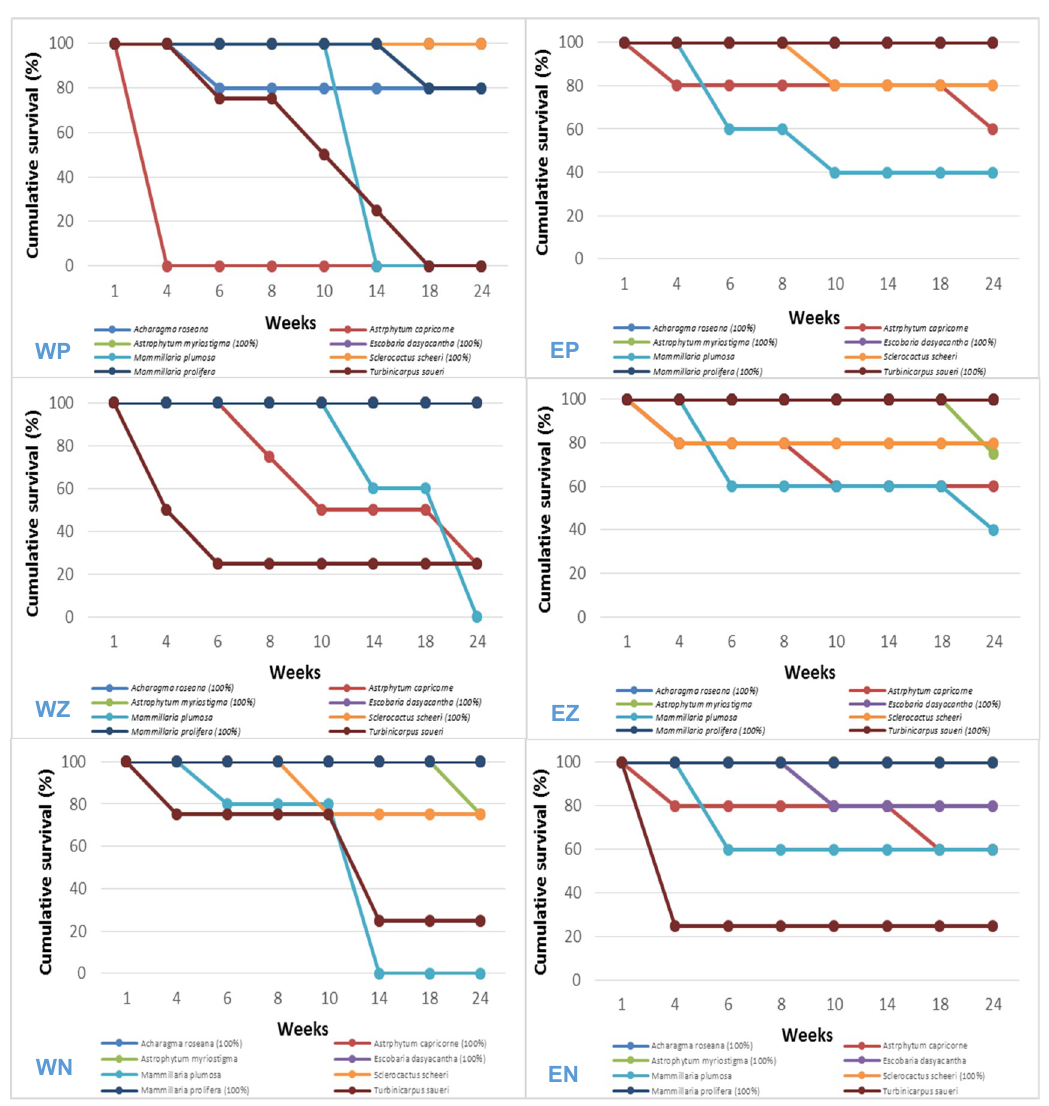
Figure 2 . Cacti survival curves during 24 weeks of evaluation in different treatments: W = West exposure, E = East exposure, P = Perlite, Z = Zeolite, NS = Natural soil. The perlite substrate at a west exposure, as well as zeolite and natural substrate at an east exposure presented strong survival (80%) with the species A. roseana , M. prolifera , S. scheeri and E. dasyacantha . Moderate survival (60–75%) was observed at east exposure, with the species Astrophytum capricorne and A. myriostigma in the zeolite substrate and M. plumosa in the natural substrate. The low survival (25–40%) was obtained at a west exposure in zeolite, with the species A. capricorne and Turbinicarpus saueri ; and at an east exposure in perlite/zeolite with M. plumosa , and an east exposure in natural substrate with M. plumosa and T. saueri . The different treatments were not favorable for the establishment of M. plumosa , since their individuals survived at the east exposure with only 40% and 60% in perlite, zeolite, and natural substrate, respectively, and 0% at the west exposure, from the 14th week. 3.2. Diameter and Height of Cacti The analysis of variance of diameter and height data showed highly significant differences ( p < 0.01) among growth parameters and sun exposure, and significant differences ( p < 0.05) with substrate (Table 2).